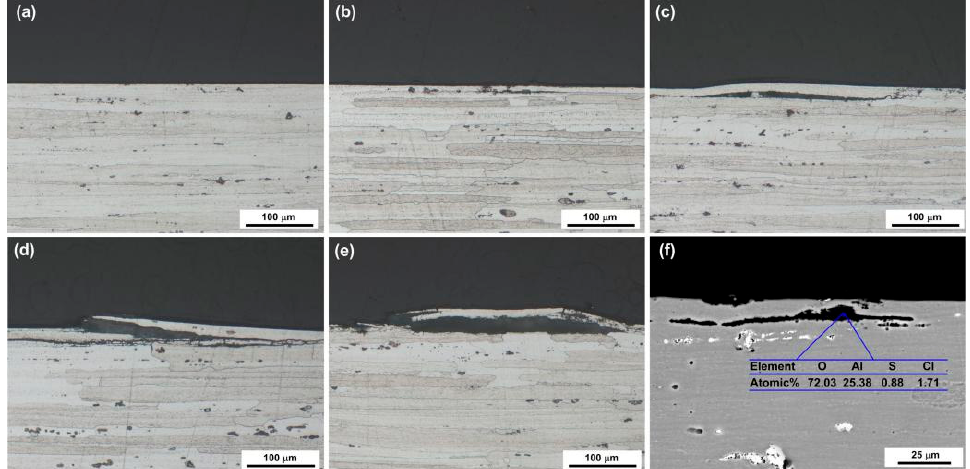
Figure 6. ( a – e ) OM and ( f ) backscattered electron images for the cross-sectional microstructures of 7075 aluminum alloy specimens subjected to outdoor exposure for different numbers of days: ( a ) 0 days; ( b , f ) 15 days; ( c ) 30 days; ( d ) 90 days; ( e ) 180 days.